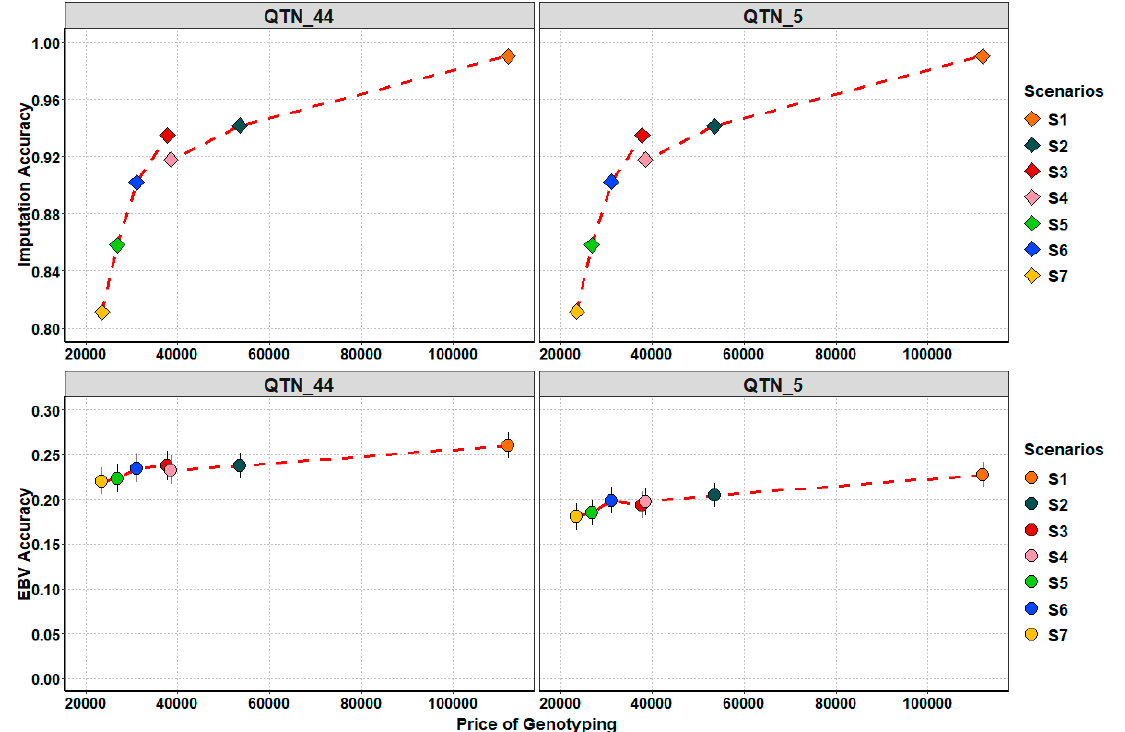
Figure 6. Plots of relationship between price of genotyping and imputation accuracy (top figure), and price of genotyping and EBV accuracy (bottom figure). Vertical lines are the mean ± standard error.